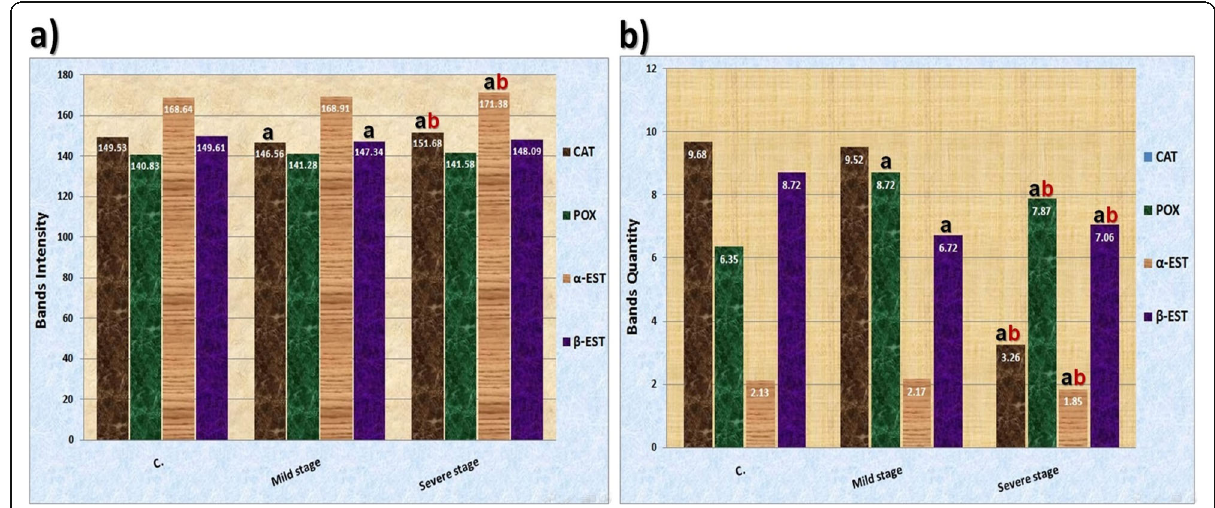
Fig. 4 Statistical comparison showing the differences in a ) Intensities and b ) Quantities of the total bands of electrophoretic catalase, peroxidase, α - and β -esterases in asthmatic bronchitis patients at mild and severe stages as compared to control (healthy individuals). a Significant difference as compared to control ( P < 0.05), b Significant difference as compared to patients at mild stage ( P <